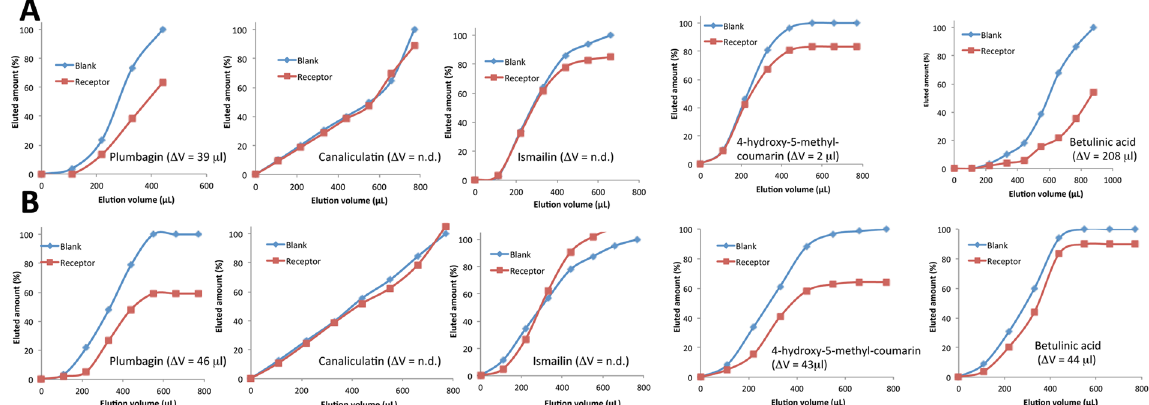
Figure 1. Breakthrough profiles of the five analytes. Elution profiles (percentage of total eluted analyte) of the five secondary metabolites of Diospyros bipindensis on receptor and blank cartridges, together with the calculated Δ v shift: Elution profile of ( A ) the single analytes, and ( B ) the analytes eluted in